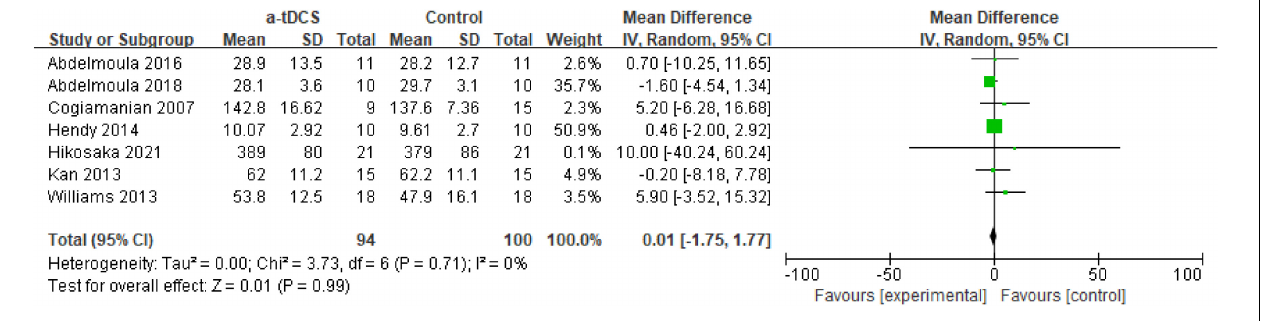
FIGURE 2 | Forest plot for the effect of a-tDCS on enhancing upper limb muscle